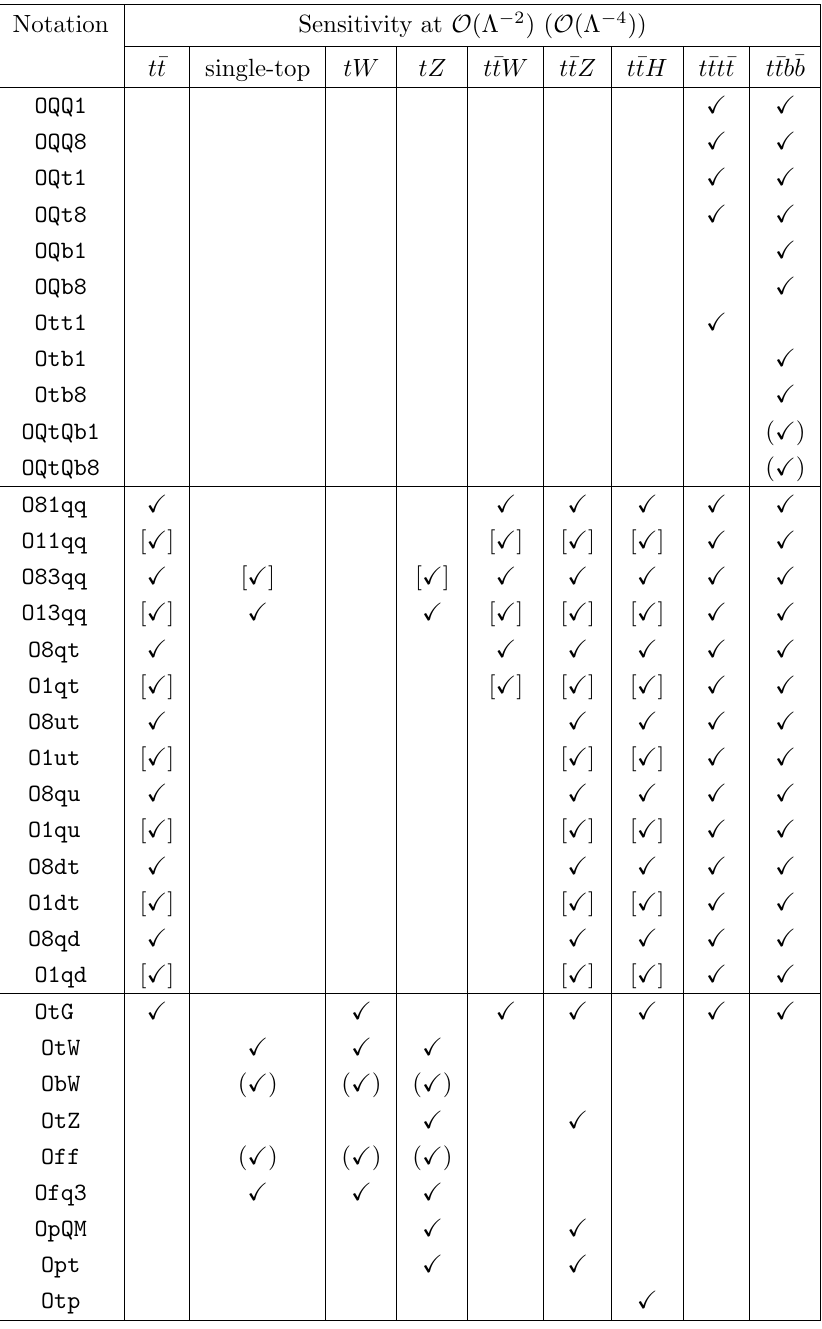
Table 6 . The sensitivity of each of the LHC processes included in the present analysis with each of the N obs = 34 dimension-six SMEFT operators that constitute our (cid:12)tting basis (see table 1 for their de(cid:12)nition). A check mark outside (inside) brackets indicates that a given process constrain the corresponding operator ((cid:3) (cid:0) 2 ) ( ((cid:3) (cid:0) 4 )), and operators in square brackets indicate that an O O operator contributes at ((cid:3) (cid:0) 2 ) but only at NLO, see text for details. O